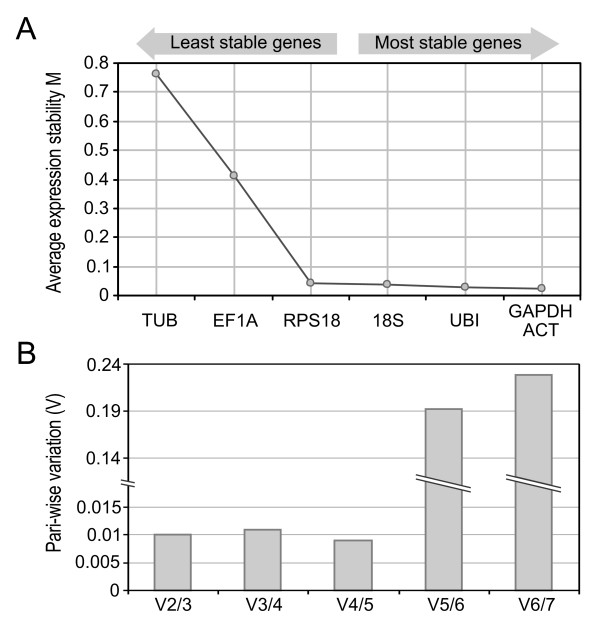
Stepwise exclusion and pair-wise variation (v) analysis by GeNorm. (A) Stepwise exclusion analysis in which the least stable (highest M value) gene is excluded sequentially (from left to right) until the most stable pair of genes remains. (B) Pair-wise variation analysis showing the normalization factor (NF) variability (V) that results from including an additional gene to the NF calculation. A V increase corresponds to a decrease in NF reliability.